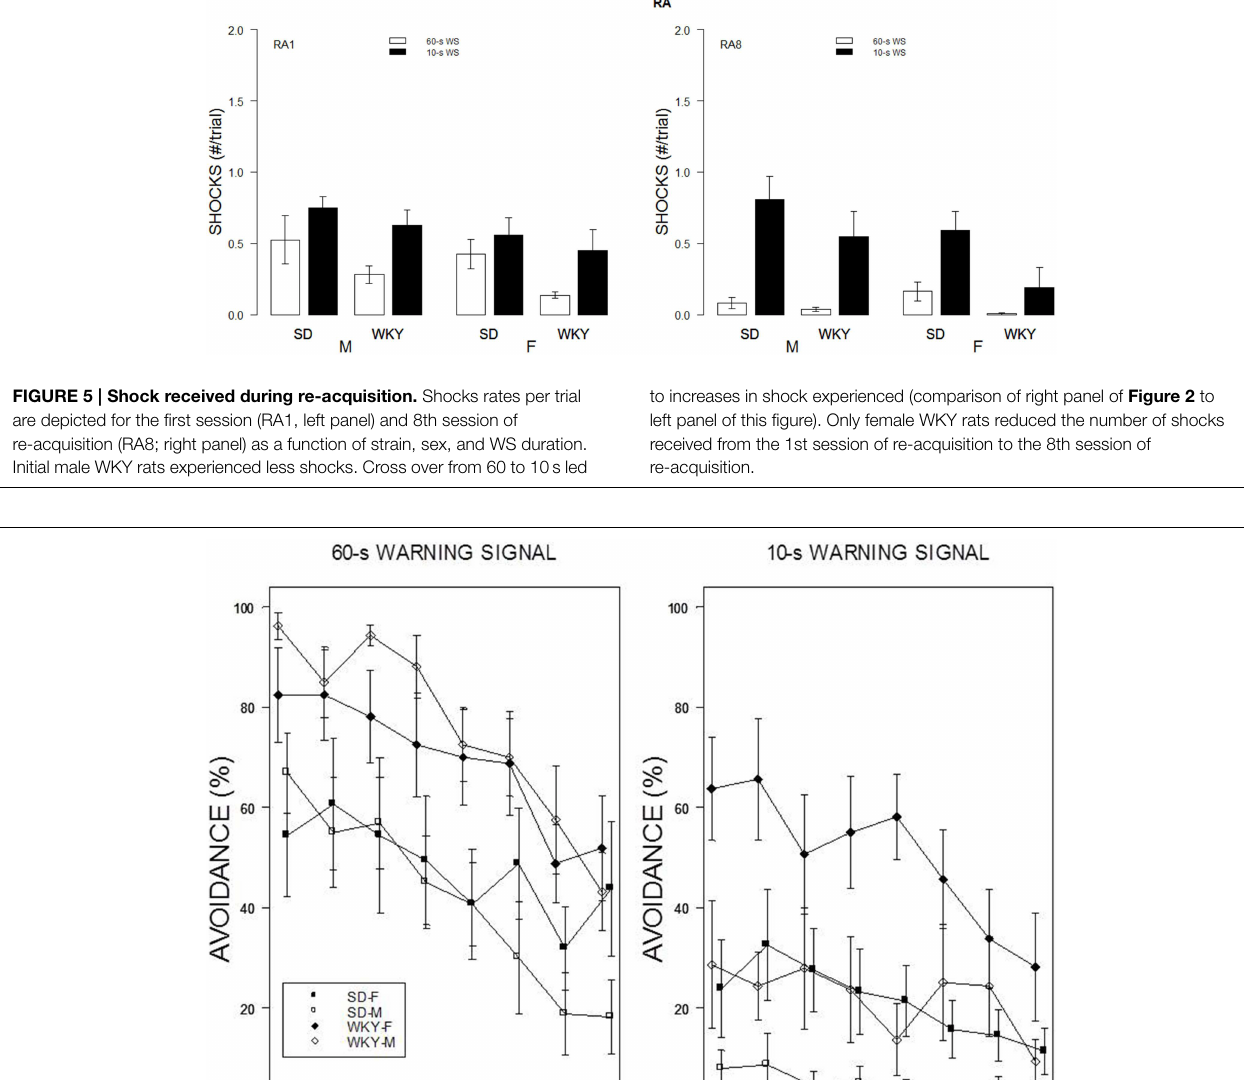
FIGURE 6 | Avoidance re-extinction. A cross-over design is depicted of re-extinction with rats trained with an initial 10-s WS, now trained with a 60-s WS (left panel), and rats trained initially with a 60-s WS, now trained with a 10-s WS (right panel). The legend is